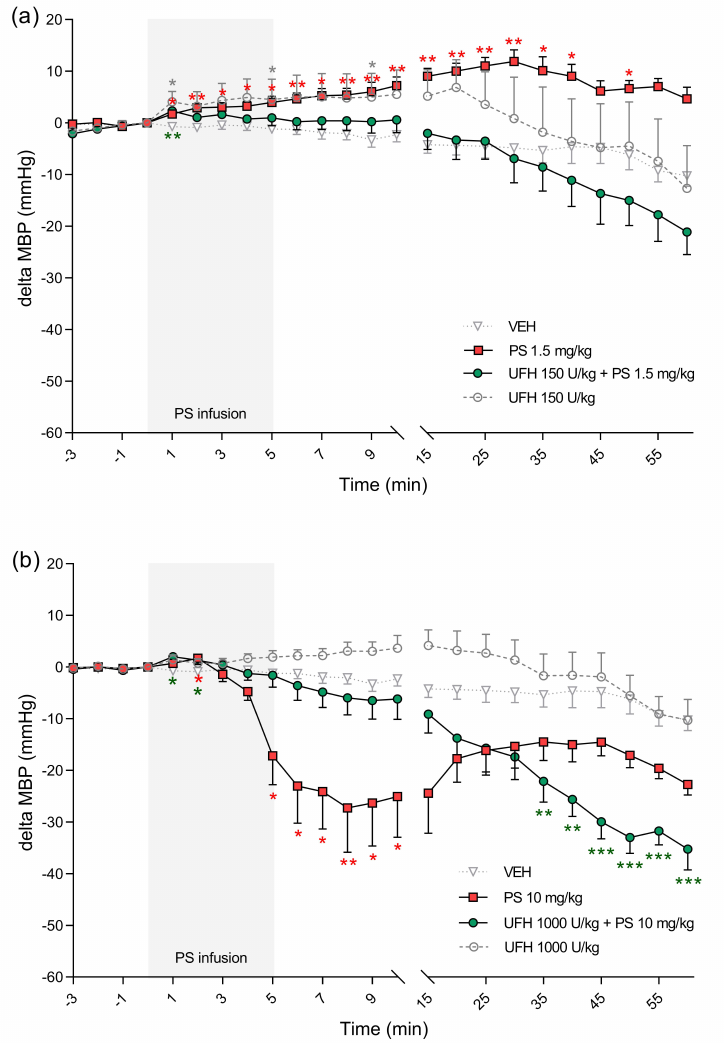
Figure 6. The effects of protamine sulfate (PS) and its complexes with unfractionated heparin (UFH) on mean blood pressure (MBP) values. The course of MBP was tracked for 60 min after short–duration intravenous infusion (5 min; 2 mL/h) of PS at a dose of 1.5 ( a ) or 10 mg/kg ( b ) following intravenous administration of vehicle (VEH, 1 mL/kg) or UFH (150 or 1000 U/kg, 1 mL/kg). Results are shown as means (lines) with SEMs. The MBP values at 0 min of the experiment were 121.4 (86.6–138.0) for VEH, 110.7 (91.1–129.4) for PS 1.5 mg/kg, 134.6 (122.8–152.7) for UFH 150 U/kg + PS 1.5 mg, 109.4 (93.1–127.4) for UFH 150 U/kg, 116.9 (108.2–135.6) for PS 10 mg/kg, 120.3 (93.5–130.8) for UFH 1000 U/kg + PS 10 mg/kg, 107.7 (95.2–126.6) for UFH 1000 U/kg. Note: * p < 0.05, ** p < 0.01, *** p < 0.001 vs. VEH, Kruskal–Wallis ANOVA with Dunn’s post–hoc test, n =